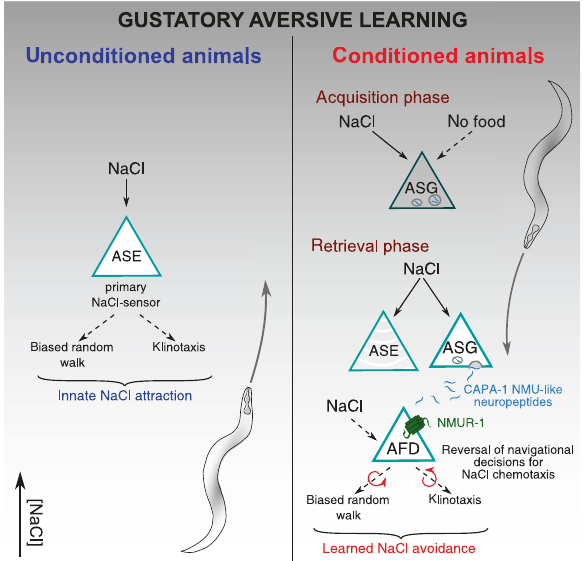
Fig. 8 Schematic model of NMU signaling in gustatory aversive